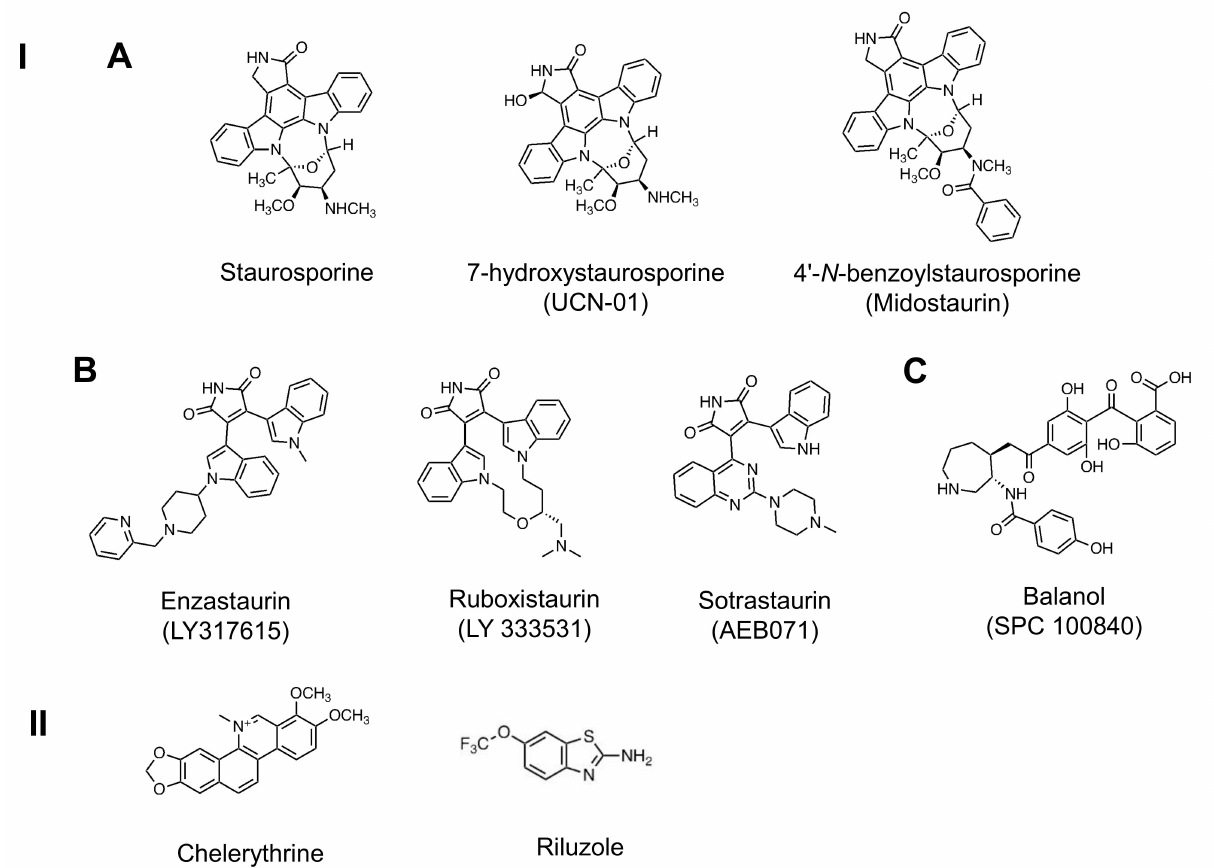
Figure 3. I. Chemical structure of C3 domain-binding inhibitors (ATP competitive PKC inhibitors): ( A ) indolocarbazole compounds, ( B ) Maleimide-based inhibitors. Bisindolylmaleimide (Bis) compounds (enzastaurin and ruboxistaurin) and sotrastaurin, and ( C ) other ATP competitive PKC inhibitor. II. Chemical structure of C4 domain-binding inhibitors (substrate competitive PKC